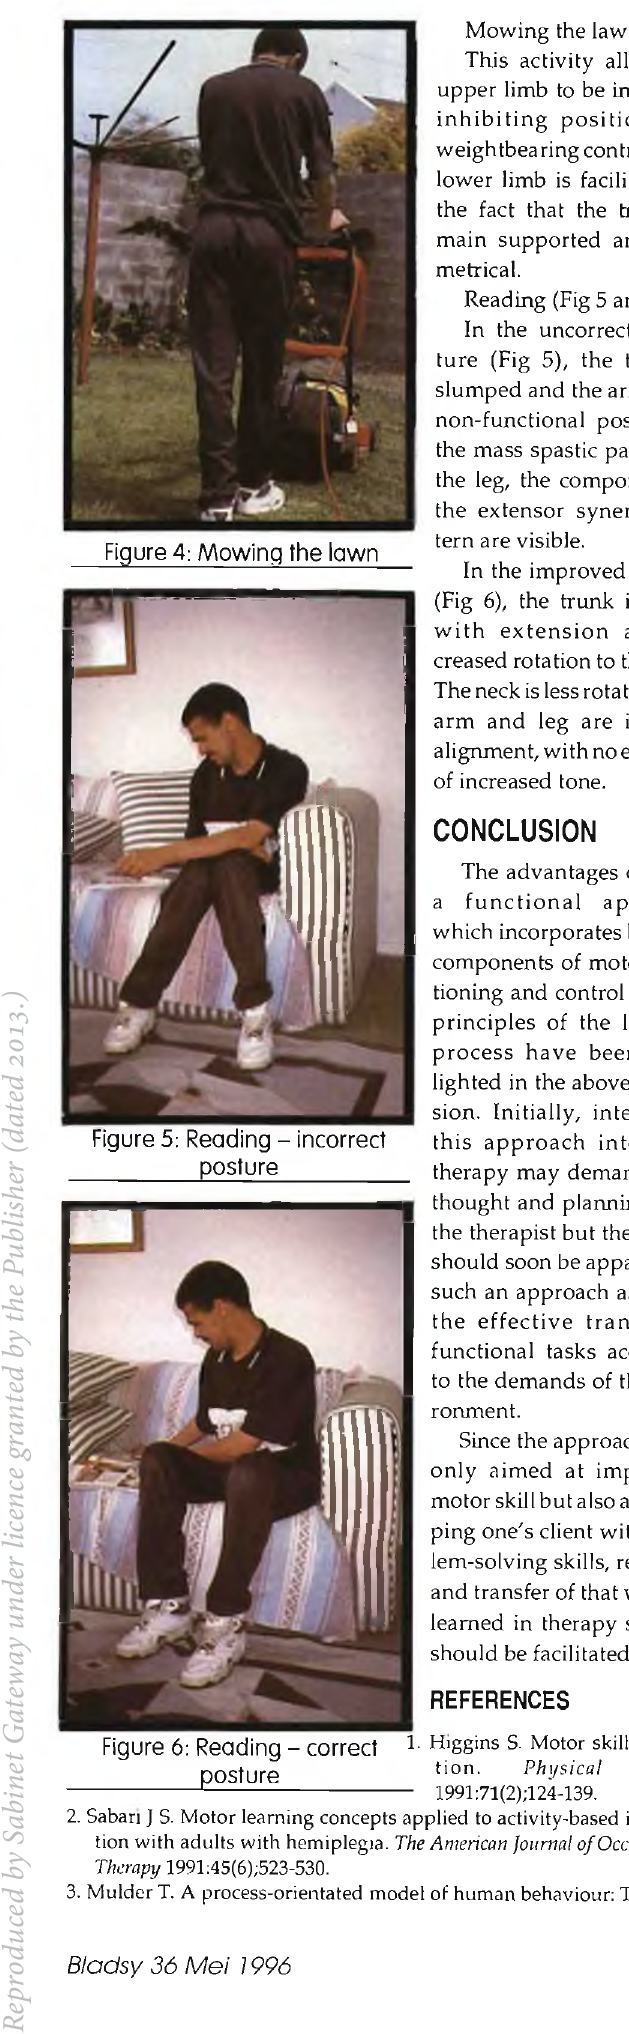
Figure 6: Reading - correct L Hissins s - Motor ski11 acquisi- DOSture tion. Physical Therapy -----------------------^----------------------------------